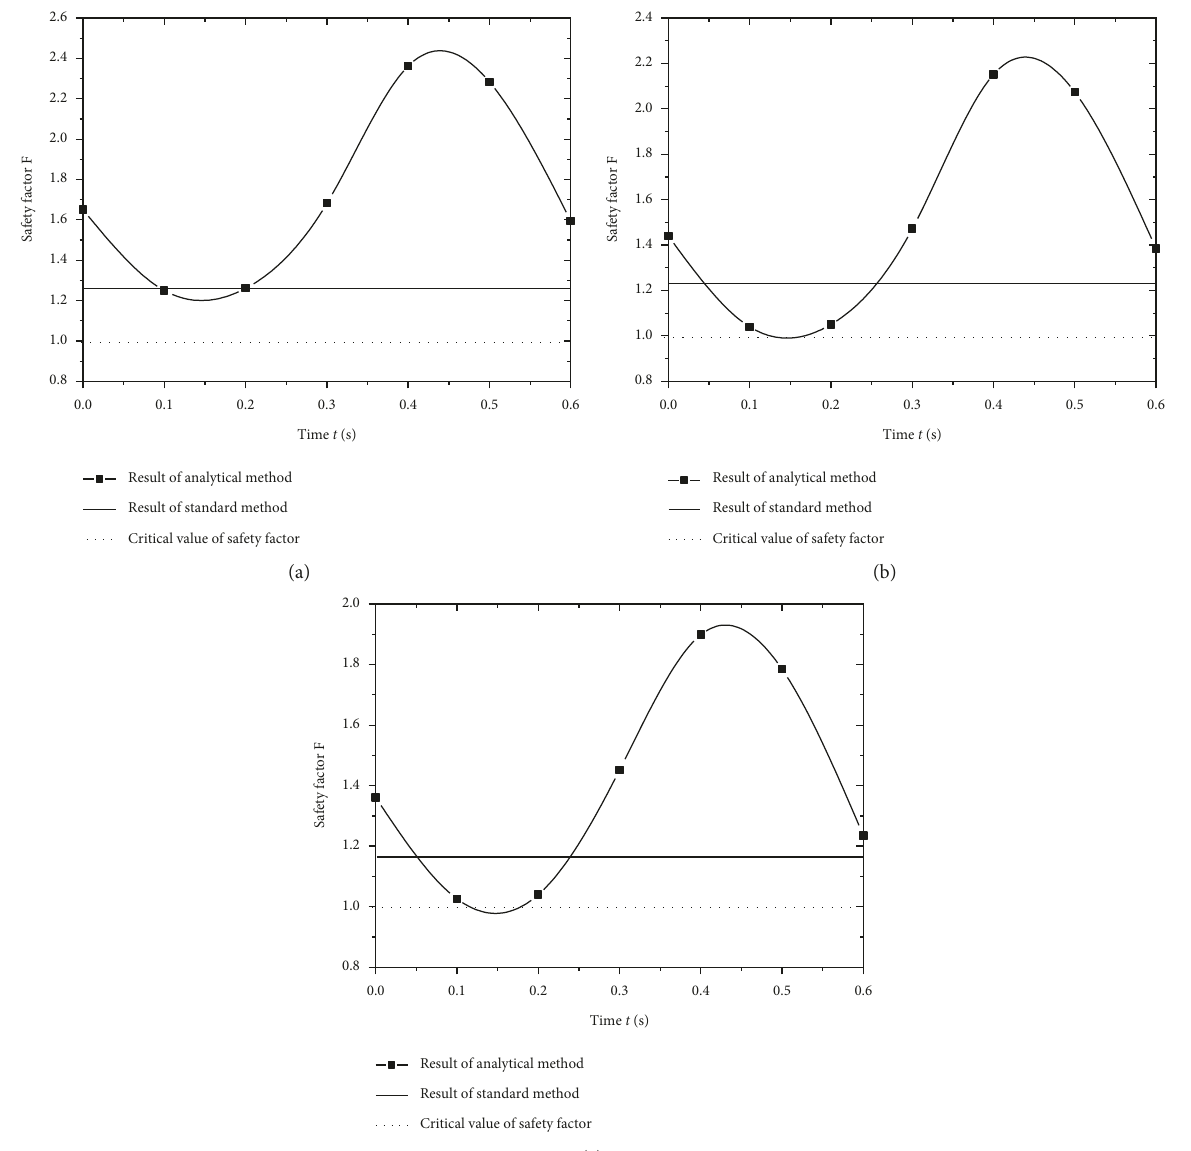
Figure 5: Safety factor comparison with different methods. (a) h � 3 m, k